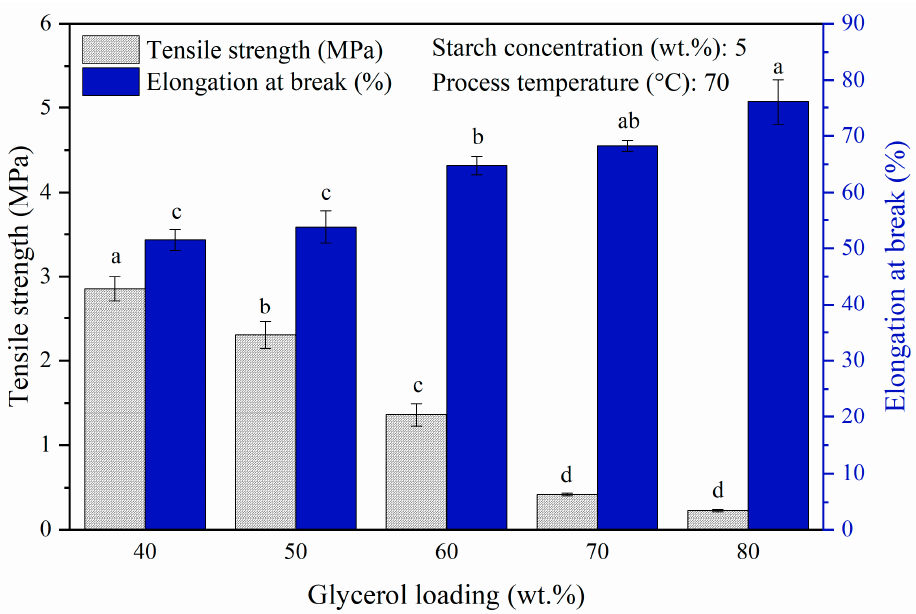
Figure 3. Tensile strength and elongation at break of pure starch-based bioplastic films with varying glycerol loadings. Different letters indicate the values are significantly different ( p < 0.05).